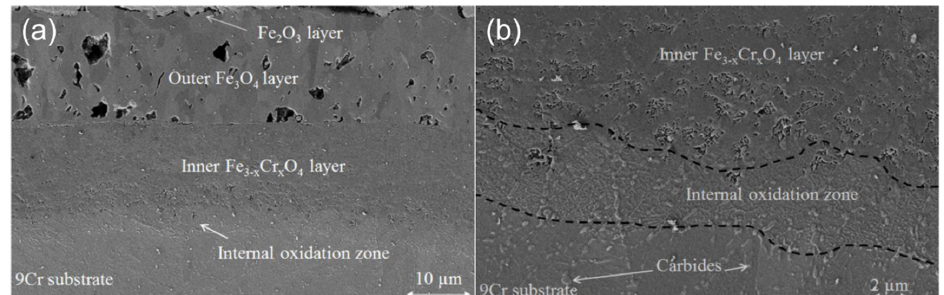
Figure 5. ( a ) Scanning electronic microscopy (SEM) cross-section image of the oxide layer on FMs T91 sample after corrosion test under flowing CO 2 at 550 °C/1 bar for 350 h. ( b ) Internal oxidation zone of ( a ) [17]. Reproduced with permission from Elsevier.